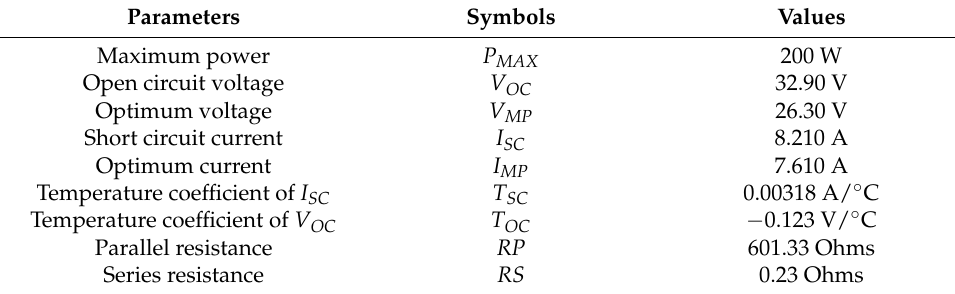
Table 3. Parameters of PV